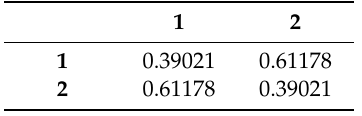
Table 2. The transition probabilities of the two hidden states, where value 1 maps to the HMM hidden state when the participant HRV components did not show any consistent decline, and value 2 maps to the HMM hidden state when the participant HRV measurements showed a consistent